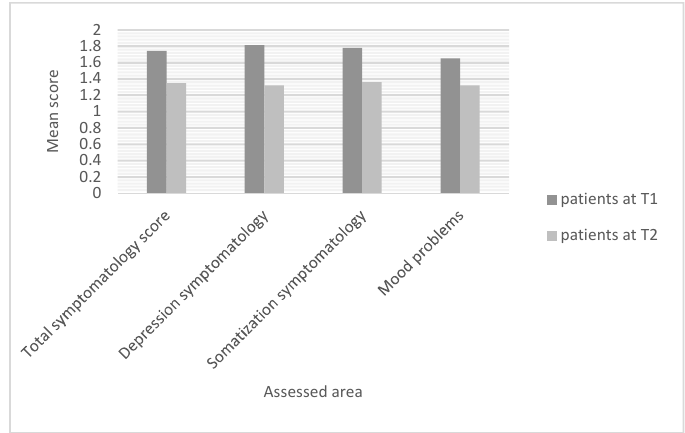
Figure 2. Patients’ symptomatology and reported problems at two time points .